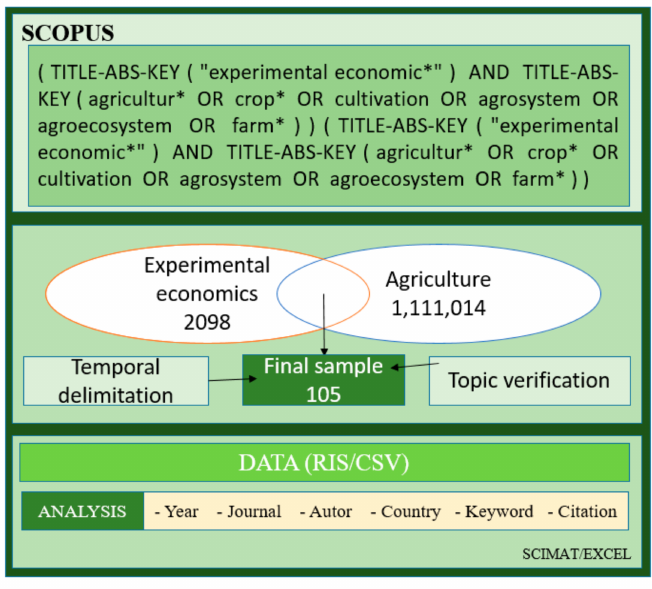
Figure 1. Summary of the